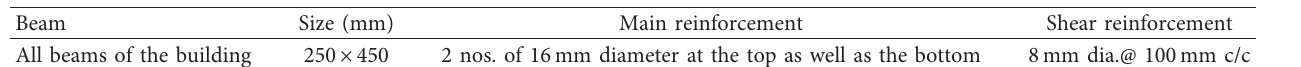
Table 4: Beam dimensions and detailing.